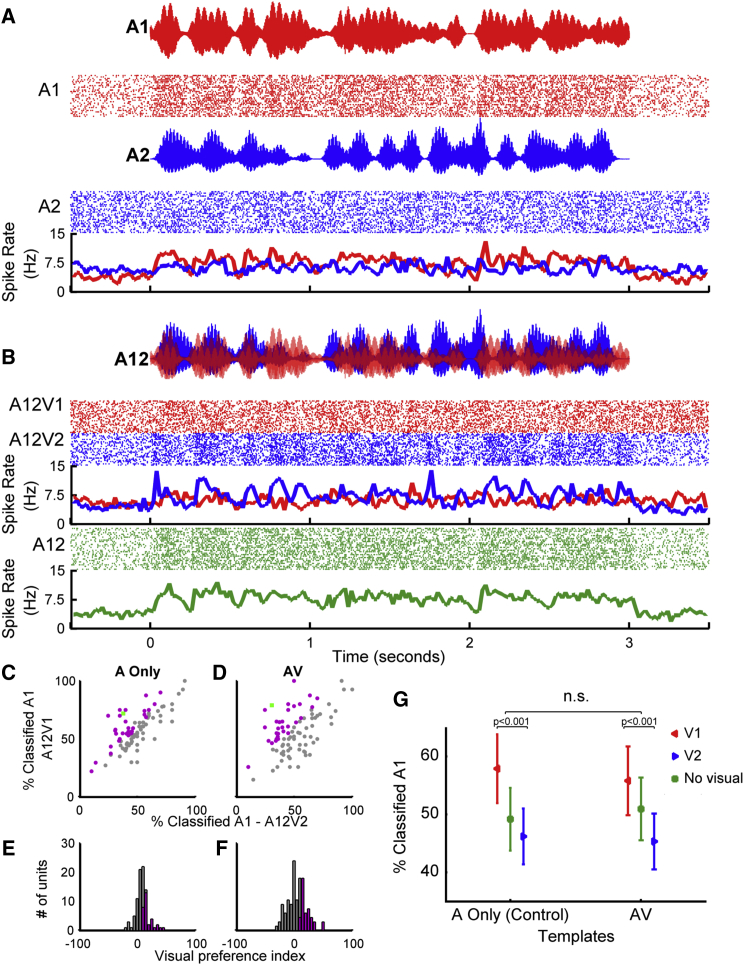
Visual Stimuli Shape the Neural Representation of an Auditory Scene(A and B) In an additional control experiment (n = 89 units recorded in awake animals), the responses to coherent auditory-visual and auditory-only (A Only) single-stream stimuli were used as templates to decode dual-stream stimuli either accompanied by visual stimuli (V1/V2) or in the absence of visual stimulation (no visual). Shown are spiking responses from an example unit in response to (A) single-stream auditory stimuli that were used as decoding templates to decode the responses to dual-stream stimuli in (B); in each case, the auditory waveform, rasters, and PSTHs are shown. In this example, when decoded with auditory-visual templates: 79% (22/28) of responses were classified as A1 when the visual stimulus was V1, and 32% of responses (9/28) were classified as A1 when the visual stimulus was V2, yielding a VPI score of 47%. When decoded with A-only templates, the values were 75% when V1 (22/28) and 35% when V2 (10/28), yielding a VPI of 40%. For comparison, the auditory-only condition (A12) is shown in green.(C and D) Population data showing the proportion of responses classified as A1 when the visual stimulus was V1 or V2 when decoded with auditory-only templates (C) or auditory-visual templates (D).(E and F) Resulting VPI scores from auditory-only decoding (E) or auditory-visual decoding (F).(G) Mean (±SEM) values for these units when decoded with A-only templates, auditory-visual templates (as in Figure 2), or in the absence of a visual stimulus.The green data point in (C) and (D) depicts the example in (A) and (B).